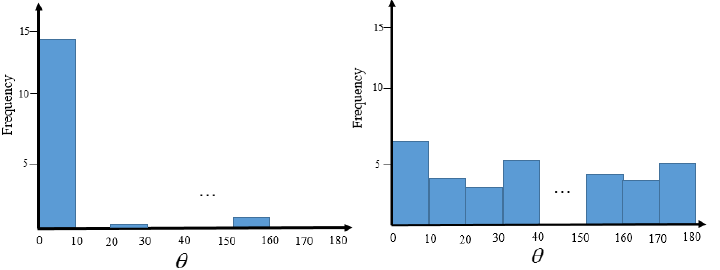
Figure 2. Demonstration of the histogram of normal orientations difference in two homogeneous and cluttered regions. cluttered